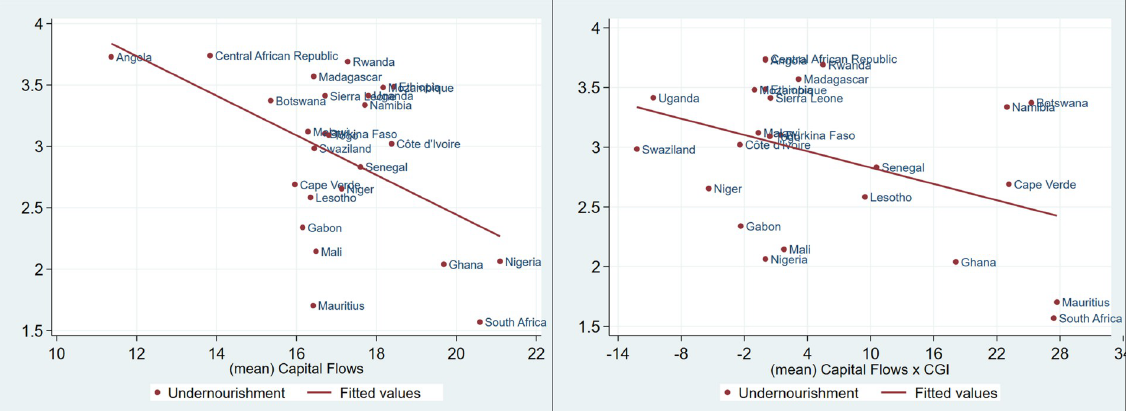
Fig 3. Undernourishment, capital flows and the interaction of governance and capital flows in SSA (1996 to 2018). Source: Authors’ analysis from FAOSTAT, WGI and WDI.